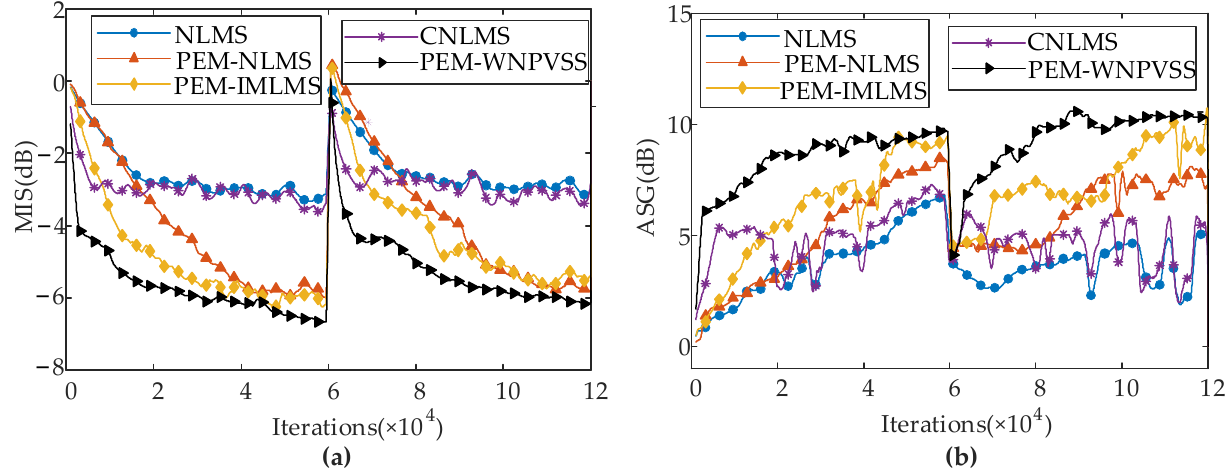
Figure 6. Performance of five algorithms with music input: ( a ) MIS; ( b ) ASG. Interference resistance: The simulation results presented in Figure 7 demonstrate the transient response of these algorithms to impulse noise. Notably, NLMS and CNLMS exhibit more susceptible to such noise, as evidenced by their large jitter range in ASG